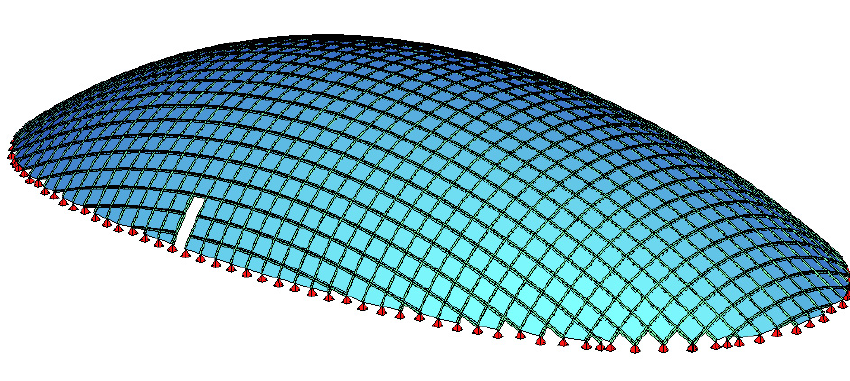
Figure 8: Grid shell structural model (© Werner Sobek Stuttgart)..